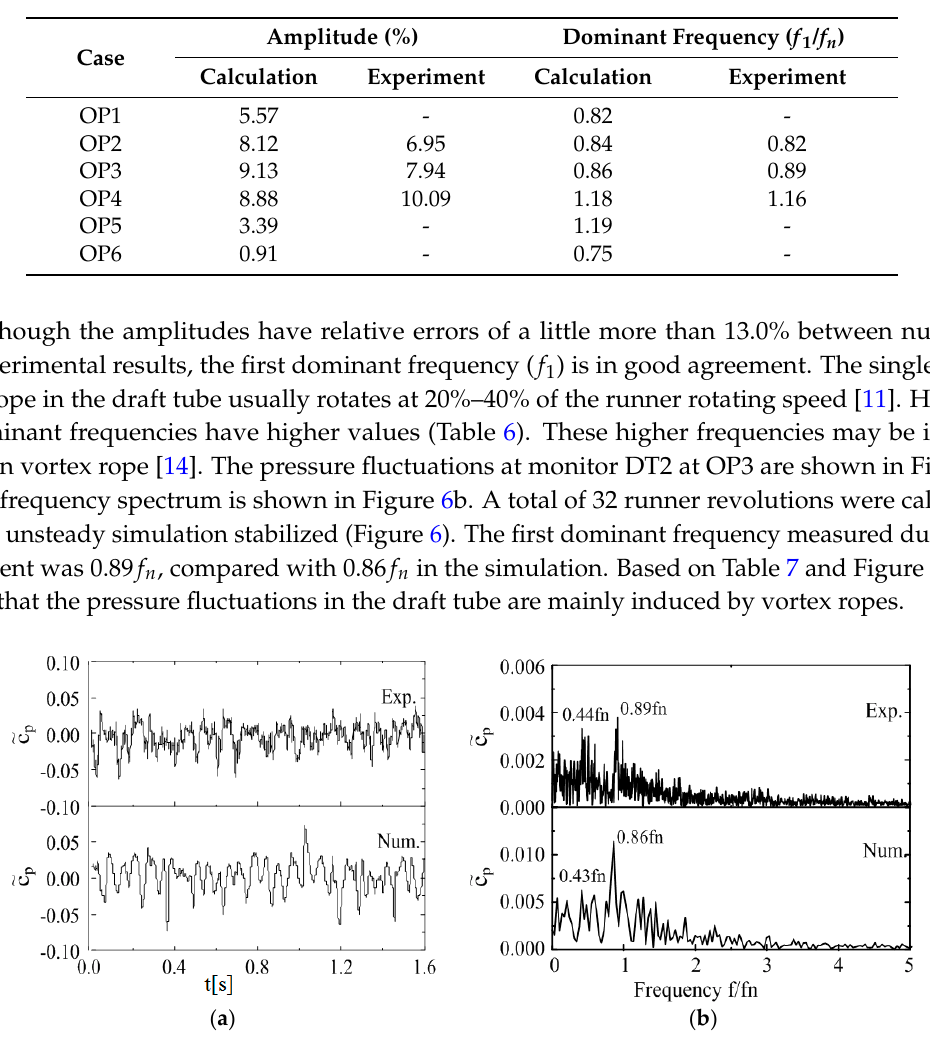
Figure 6. Measurements from monitor DT2 at OP3. ( a ) Pressure fluctuations; and ( b ) frequency